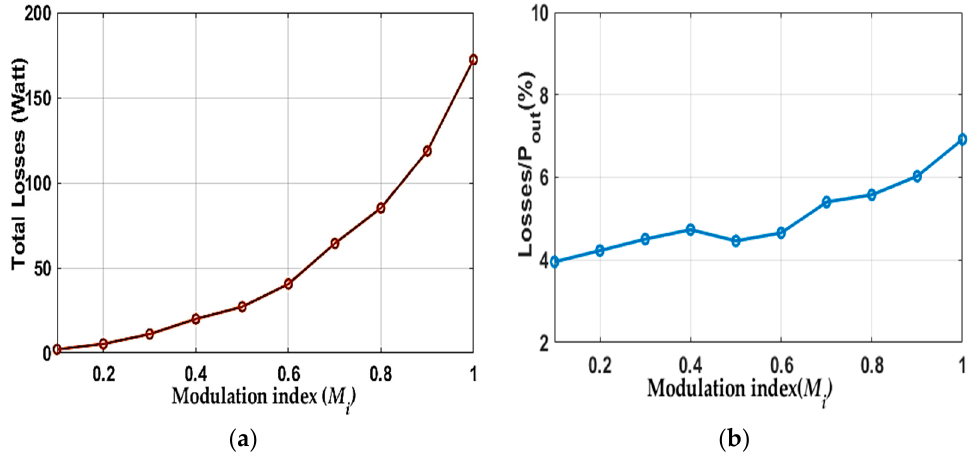
Figure 17. ( a ) Total power loss versus modulation index. ( b ) Losses as percentage of output power versus modulation index.